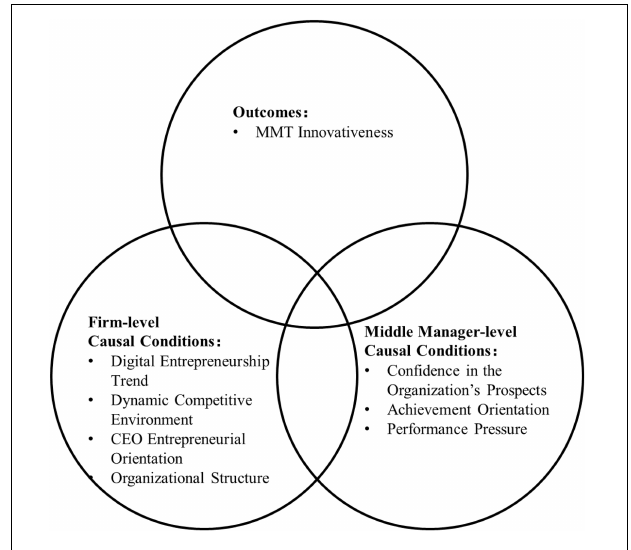
FIGURE 1 | Conceptual